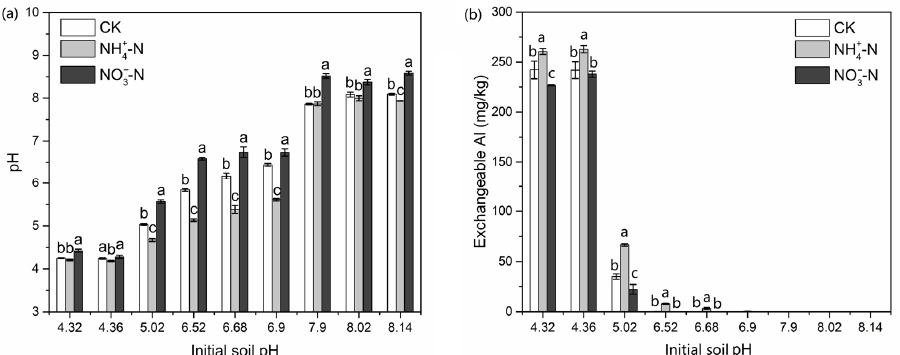
Figure 5. Soil pH and exchangeable aluminum content after maize harvest. ( a ) soil pH; ( b ) soil exchangeable Al. Maize seedlings were harvested after 30 days of growth. Different letters above bars indicate significant differences among NH 4+ , NO 3− , and control (CK) treatments in the same soil.